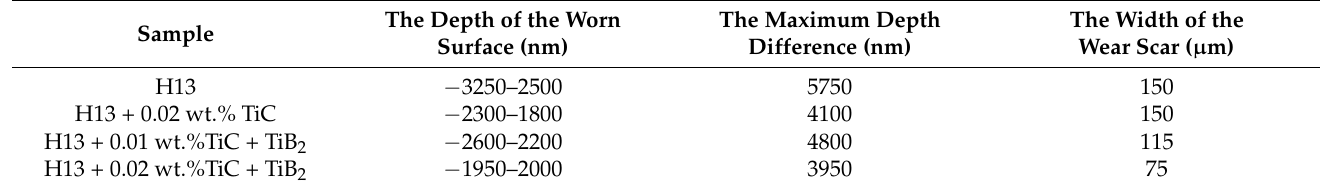
Figure 10. SEM of worn surface of H13 steels without and with nanoparticles under the load of 25 N and different sandpaper abrasive particle sizes: ( a – d ) 28 µ m and ( e – h ) 14 µ m, and white light interference of worn surface of H13 steel reinforced by nanoparticles under sandpaper abrasive particle sizes of 14 µ m: ( e 1 – e 3 ) H13, ( f 1 – f 3 ) 0.02 wt.% TiC, ( g 1 – g 3 ) 0.01 wt.% TiC + TiB 2 and ( h 1 – h 3 ) 0.02 wt.% TiC + TiB 2 . Table 6. White light interference results for H13 steels without and with nanoparticles under sandpa- per abrasive particle sizes of 14 µ m and the load of 25